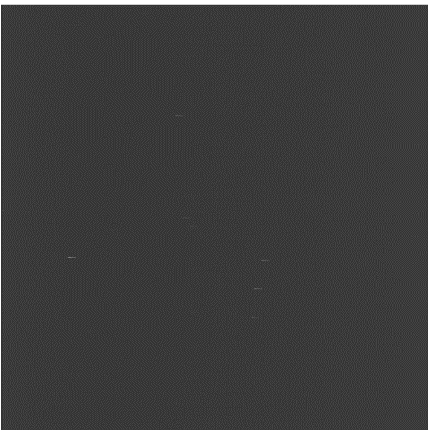
Figure 21. Real blur star image.